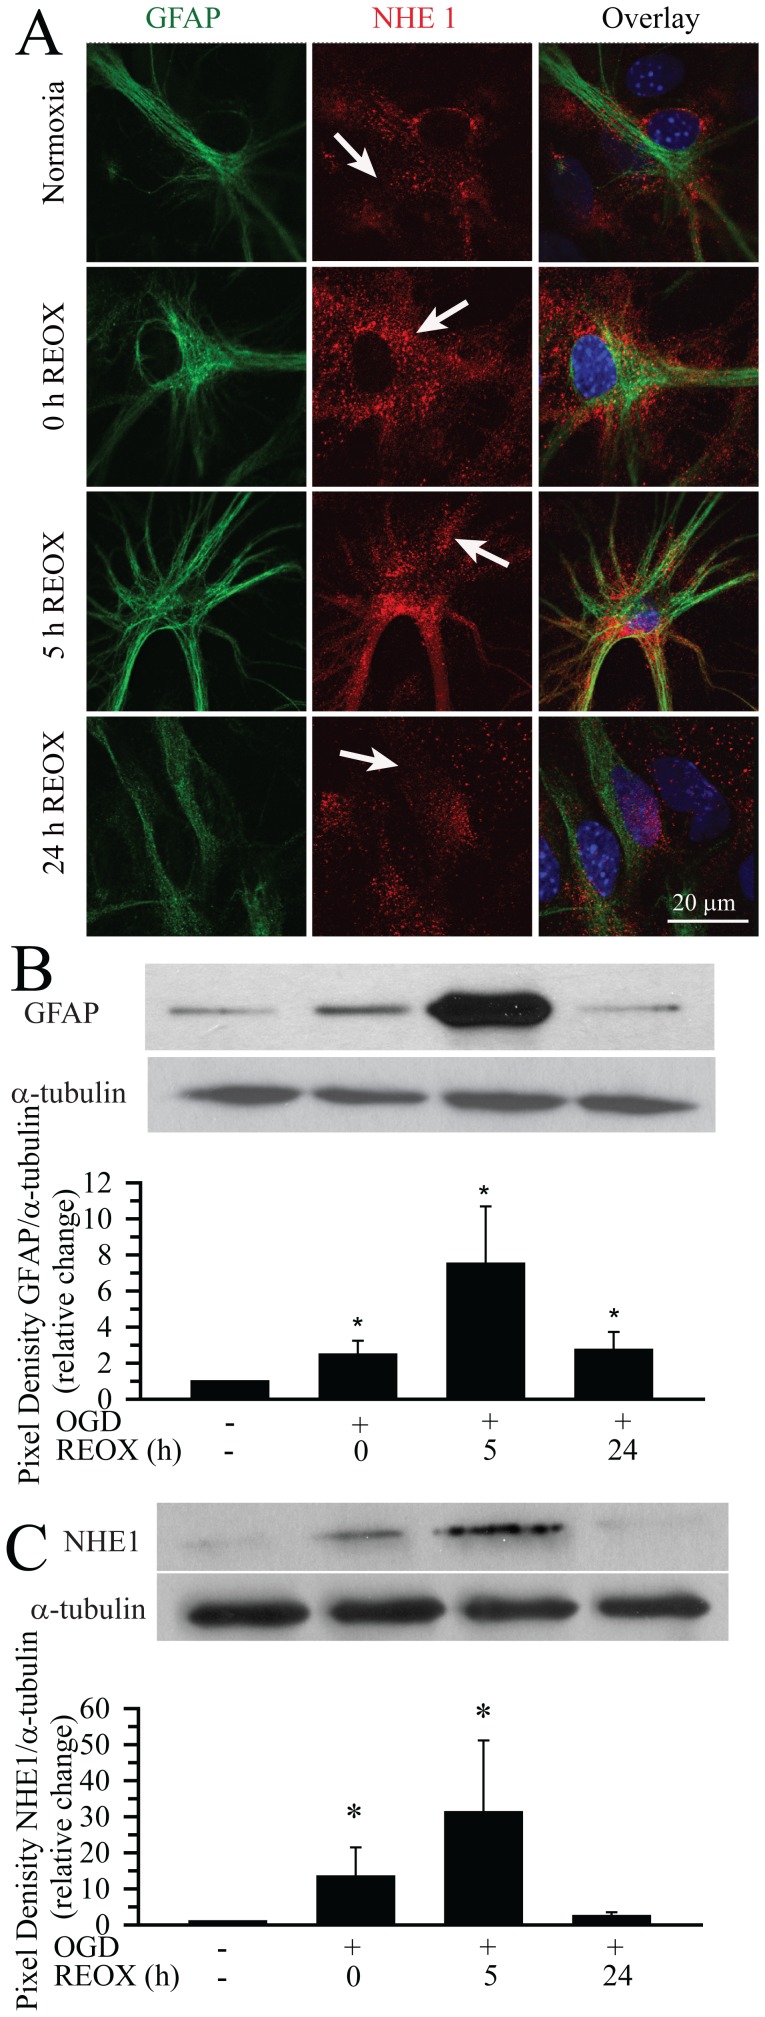
Up-regulation of NHE1 protein expression in reactive hippocampal astrocytes.
A. Expression of NHE1 protein in hippocampal astrocytes. Immunofluorescence signals of NHE1 and GFAP were shown under normoxia control or OGD (2 h) plus 0 h, 5 h, or 24 h REOX. Green: GFAP, red: NHE1 (arrows), blue: To-pro-3 nuclear staining. Scale Bar: 20 µm. B, C. Quantification of GFAP (B) and NHE1 protein (C) expression with immunoblotting. Hippocampal astrocytes were subjected to 2 h OGD followed by 5 or 24 h REOX. Total pixel density in each protein band (minus background) was calculated using Image J. Data are expressed as the ratio of either GFAP or NHE1 to the corresponding α-tubulin band and normalized to the control. Data are mean ± SEM (n = 4). *p<0.05 vs. normoxia.